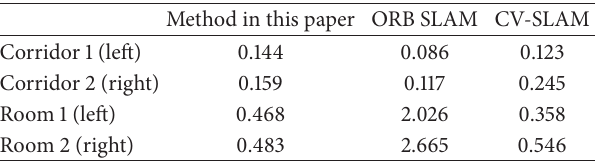
Table 1: Position RMSE comparison